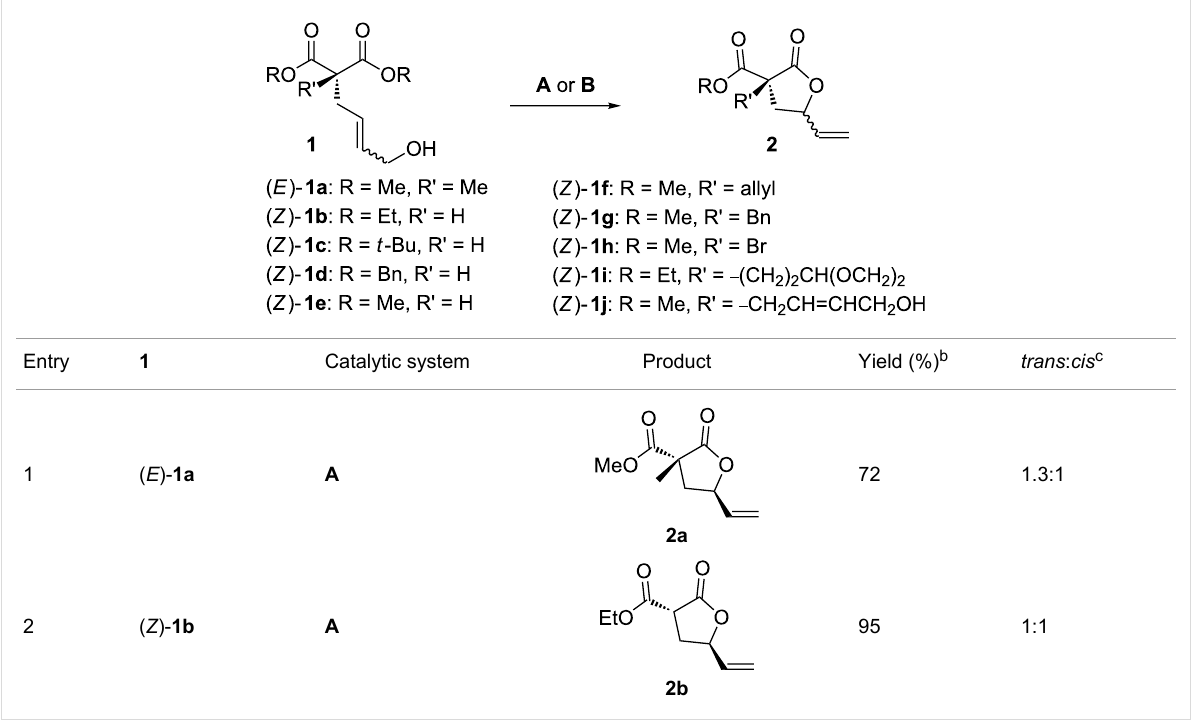
Table 2: Proving the scope of the gold-catalyzed intramolecular allylation of 1 . a